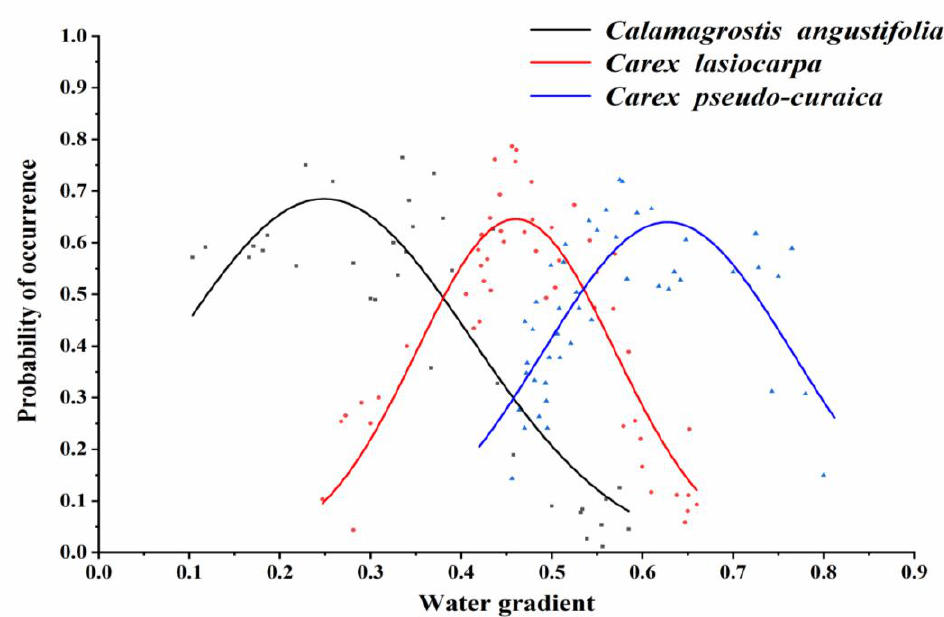
Figure 5. Species response curves for the hydrological gradient based on the probability of occurrence indicated by the Gaussian model for wetland vegetation.